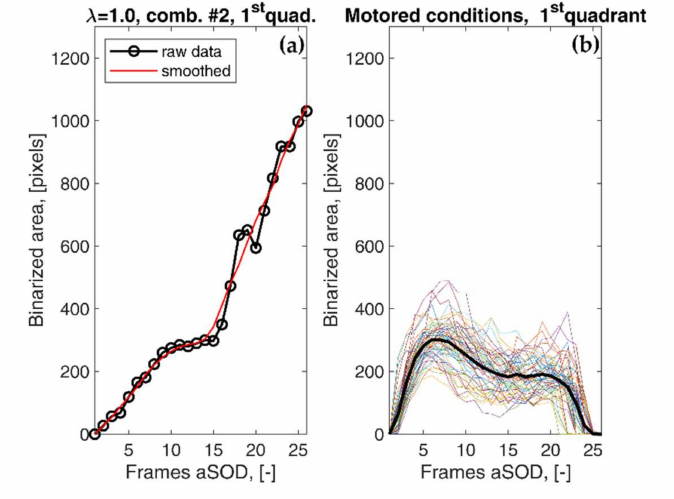
Figure 8. ( a ) Example of binarized area evolution during combustion ( λ = 1.0, combustion #2, first quadrant); ( b ) binarized area in motored conditions. Colored curves refer to each single discharge event; the black curve is the corresponding